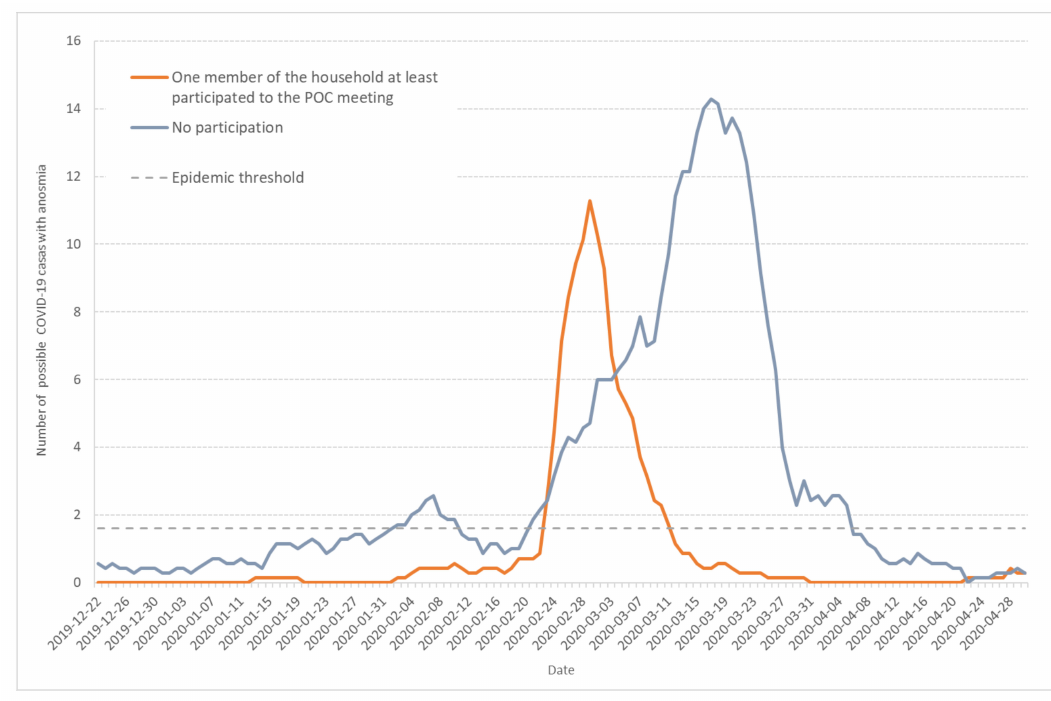
Figure 7. Seven-day moving average of daily incidence for possible COVID-19 cases that documented anosmia among Haut-Rhin households. Orange line corresponds to households in which at least one member participated to the POC gathering in Mulhouse (17–21 February 2020) and grey line to households without participants to the POC